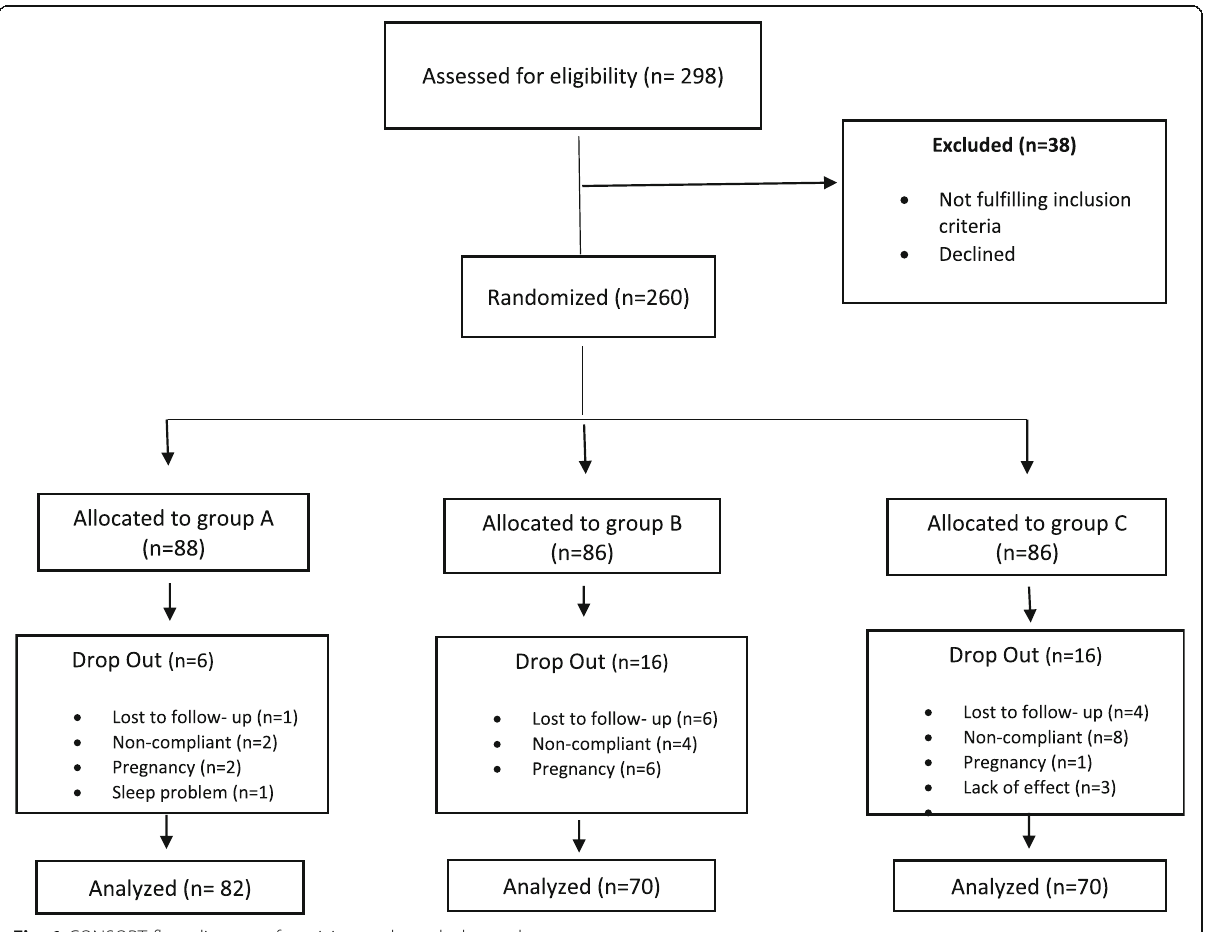
Fig. 1 CONSORT flow diagram of participants through the study